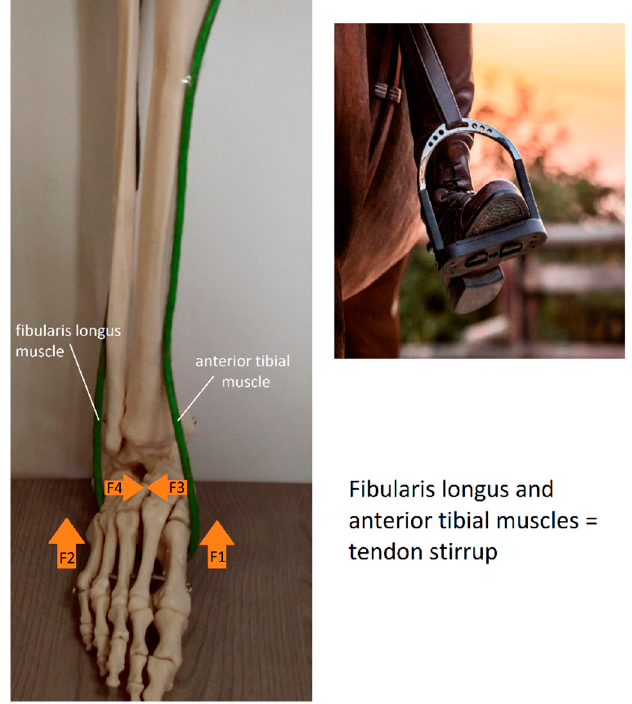
Figure 3. Distribution of pulling forces (F1, F2, F3, F4) presented in the tendon stirrup model (green loop). Vectors F1 and F2 have the same direction; their force values add up to strengthen the lifting force of the longitudinal arch of the foot. Vectors F3 and F4 oppose each other, producing contraction between the lateral and the medial base of the transverse arch, deepening it.